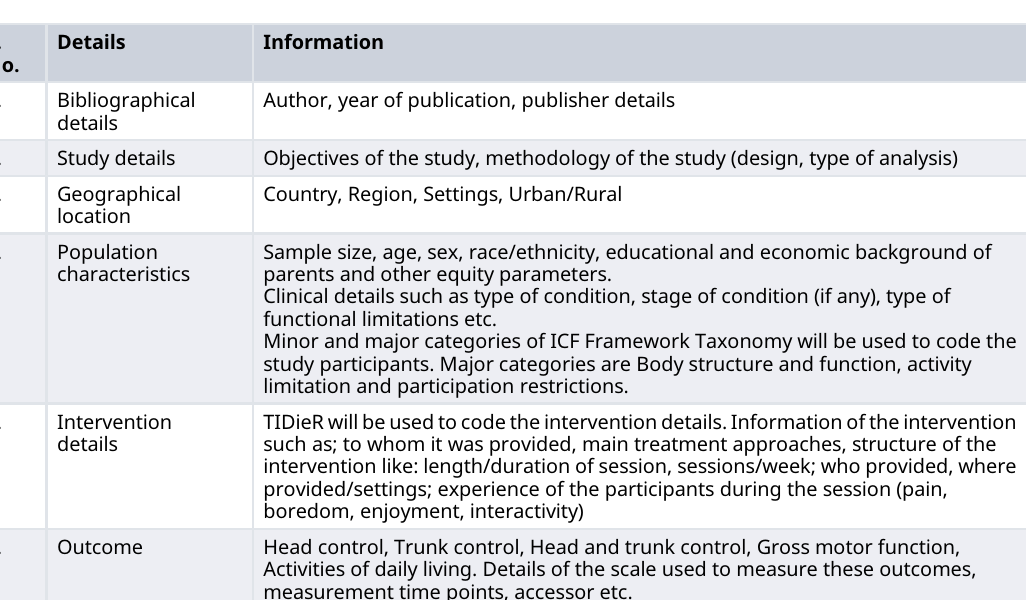
Table 1. Preliminary data coding